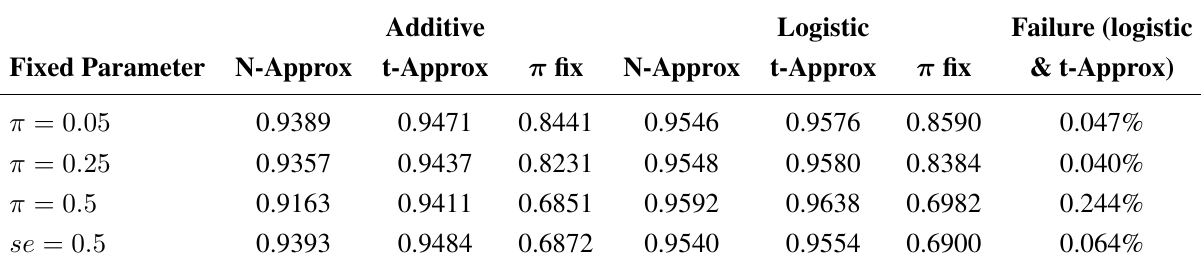
Table A1. Summary of p coverage probabilities where the cell values denote the coverage − probability for one fixed parameter and averaging over the remaining parameters.